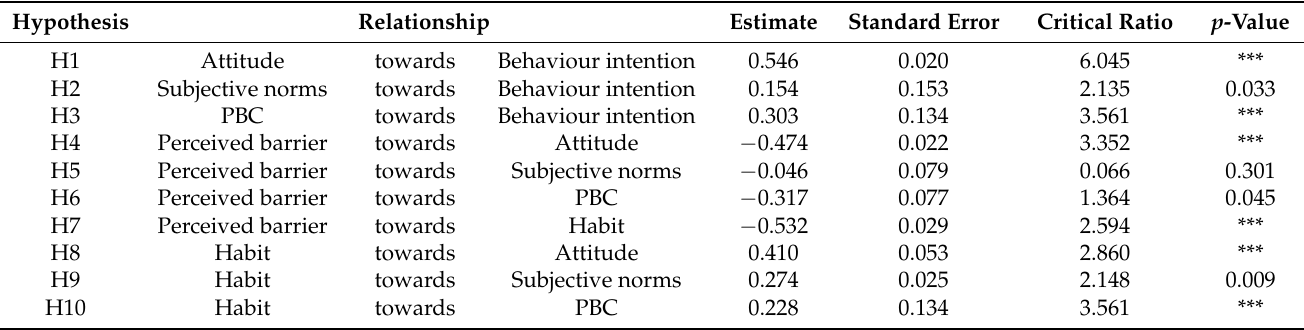
Table 5. Summary of hypothesis testing